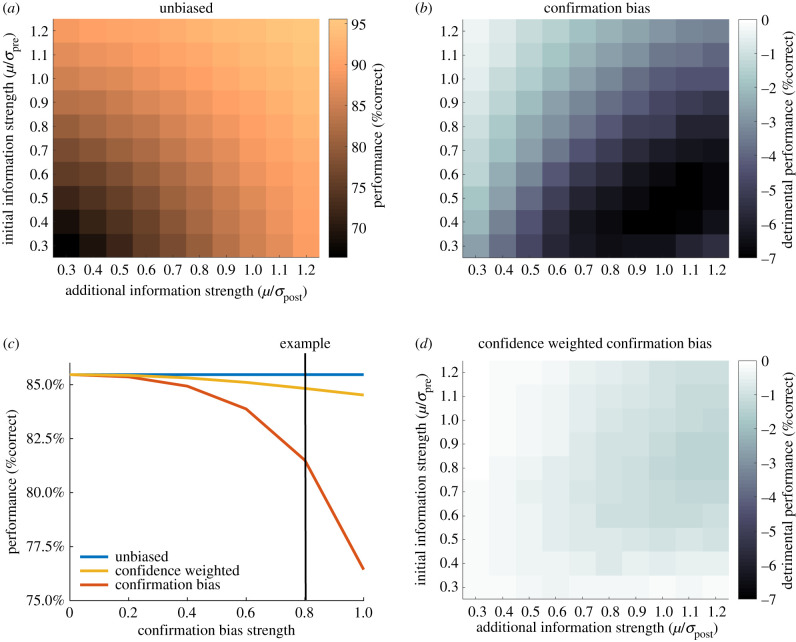
Comparison of agents' performance with different biases in information processing. (a) Performance of an unbiased agent that integrates initial and additional information in a Bayesian manner. Depending on the evidence strength, this agent shows different levels of accuracy, with better performance when both evidence samples are strong/reliable. (b) Difference in performance between an unbiased agent and a confirmation-biased agent as a function of the reliability of the initial and additional evidence. A confirmation bias has especially detrimental effects when initial evidence is relatively weak. (c) Comparison of unbiased, confirmation-biased and metacognitive (confidence-weighted) agents as a function of confirmation bias strength. Performance is averaged over all combinations of initial and additional evidence strengths. The vertical line indicates the strength of confirmation bias used in (b) and (d). (d) Difference in performance between an unbiased agent and a metacognitive agent as a function of the reliability of initial and additional evidence. Overall, the metacognitive agent shows only a relatively small disadvantage in comparison to an unbiased agent. In comparison to a simple confirmation bias, the metacognitive agent suffers less performance detriment in situations with weak initial evidence. (b,d) Dark colours indicate more detrimental performance of confirmation bias strategies when compared with unbiased evidence integration.